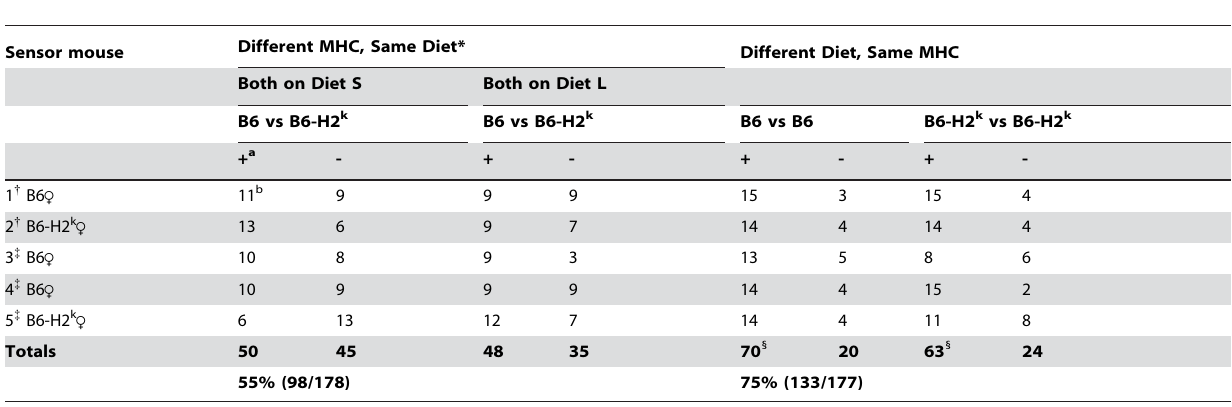
Table 1. Responses to urine odor choices for Behavior Experiment 1.